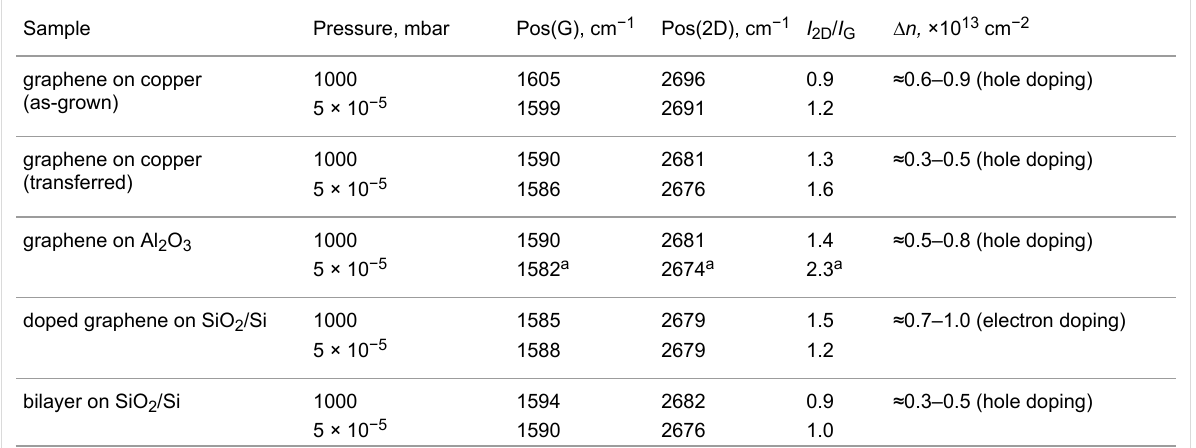
Table 1: Summarized Raman spectra parameters and resultant doping change as the pressure decreased from normal to reduced pressure for various graphene samples. For all samples except the nitrogen-doped graphene, ∆ n indicates a hole density decrease (removal of hole-inducing adsorbates from the sample surface). For doped graphene, it corresponds to an increase of electron density (similar desorption process that cancel the balancing role of adsorbed